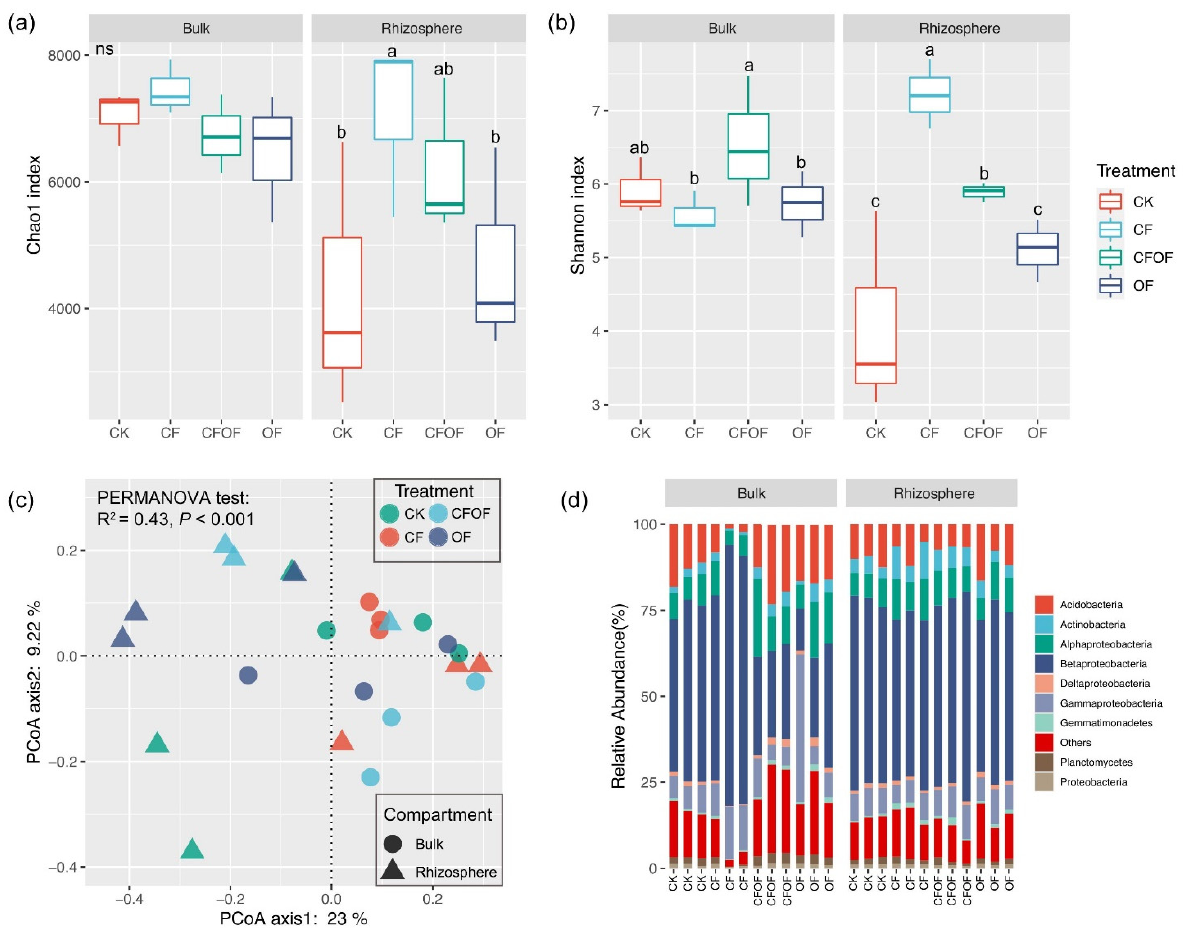
Figure 3. Alpha-diversity indices including Chao1 ( a ) and Shannon ( b ) in bulk and rhizosphere soil bacteria. Bacterial community structure ( c ) and composition ( d ) change under different fertilization treatments. CK, control treatment; CF, 100% chemical fertilizer; CFOF, 50% chemical fertilizer +50% bio-organic fertilizer; OF, 100% bio-organic fertilizer. Different letters in rows indicated significant differences at p < 0.05.